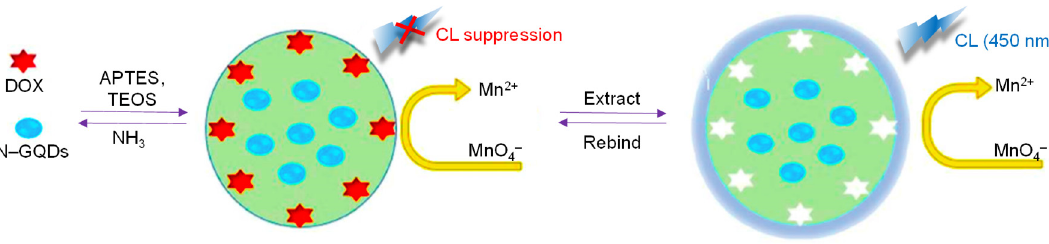
Figure 8. Construction of MIP@N-GQDs based chemiluminescence (CL) sensor for the quantification of doxorubicin [178]. Reproduced by permission of The Royal Society of Chemistry. APTES: Aminopropyltriethoxysilane; TEOS: Tetraethoxysilane.